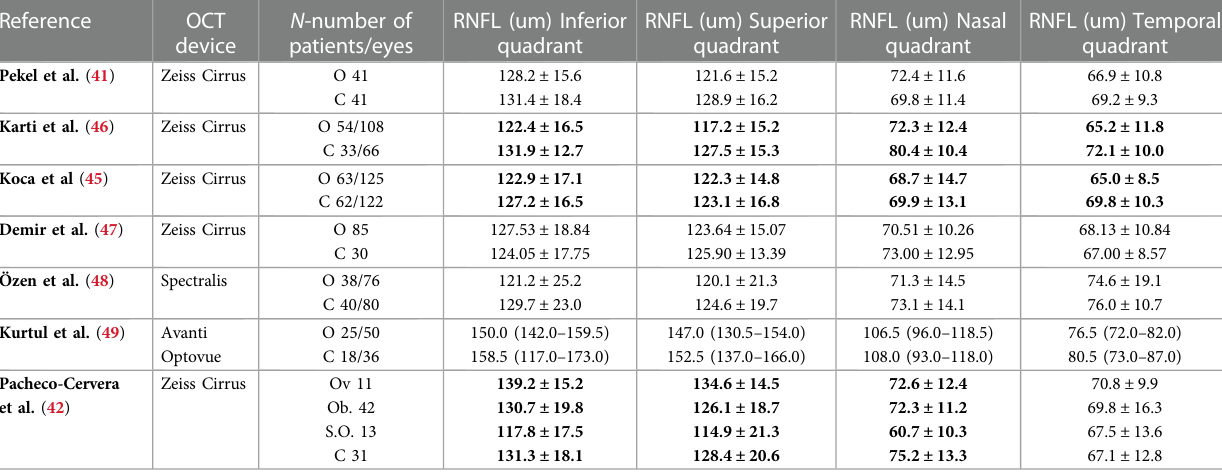
TABLE 1 Summary of reported values of OCT RNFL in obese children and adolescents (mean±) or median (min-max) in literature. Reference